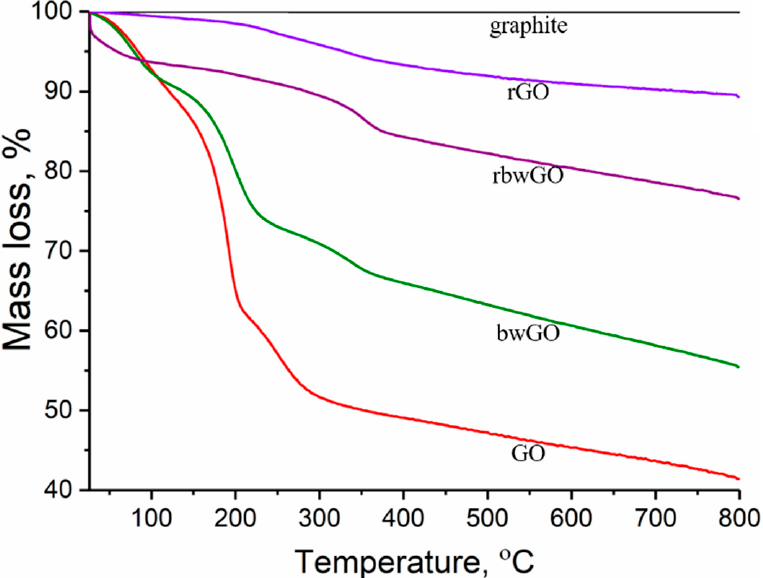
Figure 7. Thermogravimetric results of graphene oxide samples.